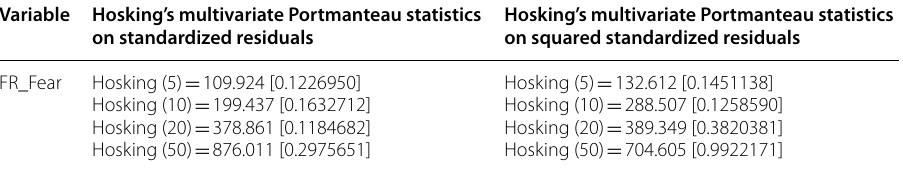
Table 8 Multivariate tests of residuals